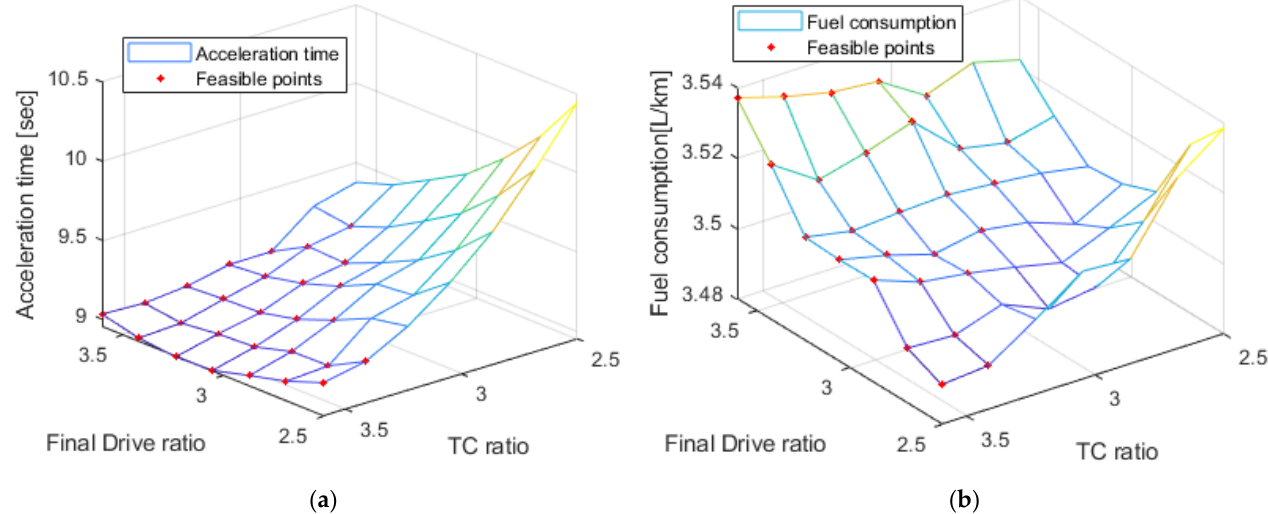
Figure 10. Results on entire range of versus TC and FD and feasible points: ( a ) acceleration results; and ( b ) fuel consumption results.